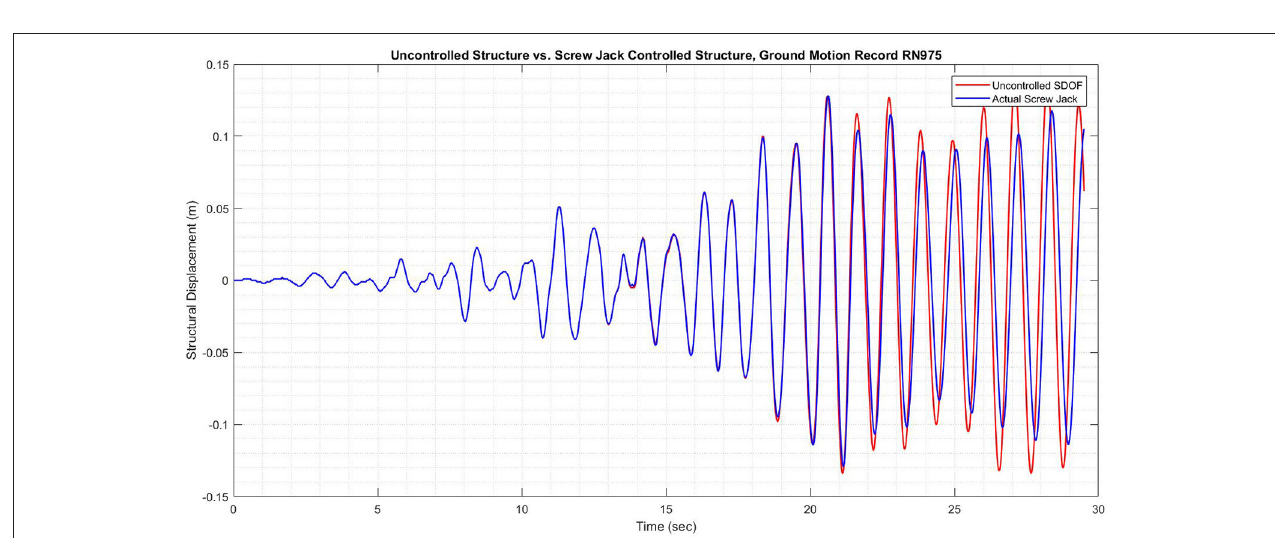
FIGURE 10 | Results for all four scenarios showing reductions to key structural parameters (obtained through numerical simulation).